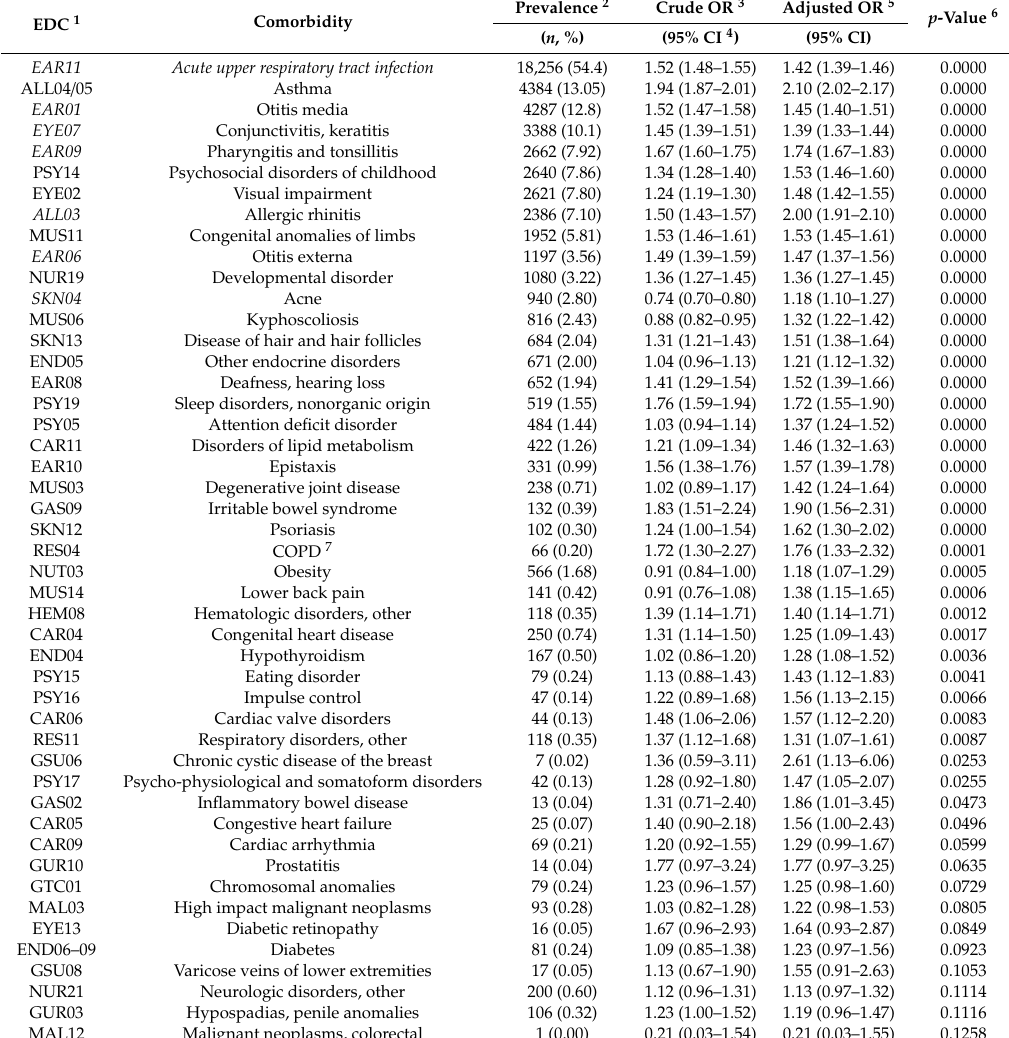
Table 4. Prevalence of chronic comorbidities and of specific acute conditions (in italics) in children aged 0–17 years with atopic dermatitis (AD) in the EpiChron Cohort in 2015 ( n = 33,591). Logistic regression models were used to calculate odds ratios (OR) of prevalence for each comorbidity (dependent variable) according to the presence or not of AD (independent variable). HIV—human immunodeficiency virus; AIDS—acquired immune deficiency